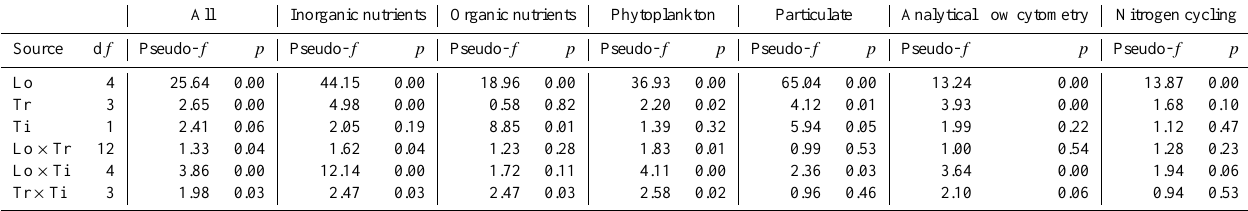
Table 3. Summary of results from permutation-based analysis of variance tests for differences among parameter groups using Type III sums of squares based on 999 permutations of residuals under a reduced model. Details of the parameters included in parameter groups are provided in Table 2. Location (Lo) was included as a random factor, while treatment (Tr) and time (Ti) were fixed. All Inorganic nutrients Organic nutrients Phytoplankton Particulate Analytical flow cytometry Nitrogen cycling Source d f Pseudo- f p Pseudo- f p Pseudo- f p Pseudo- f p Pseudo- f p Pseudo- f Pseudo-